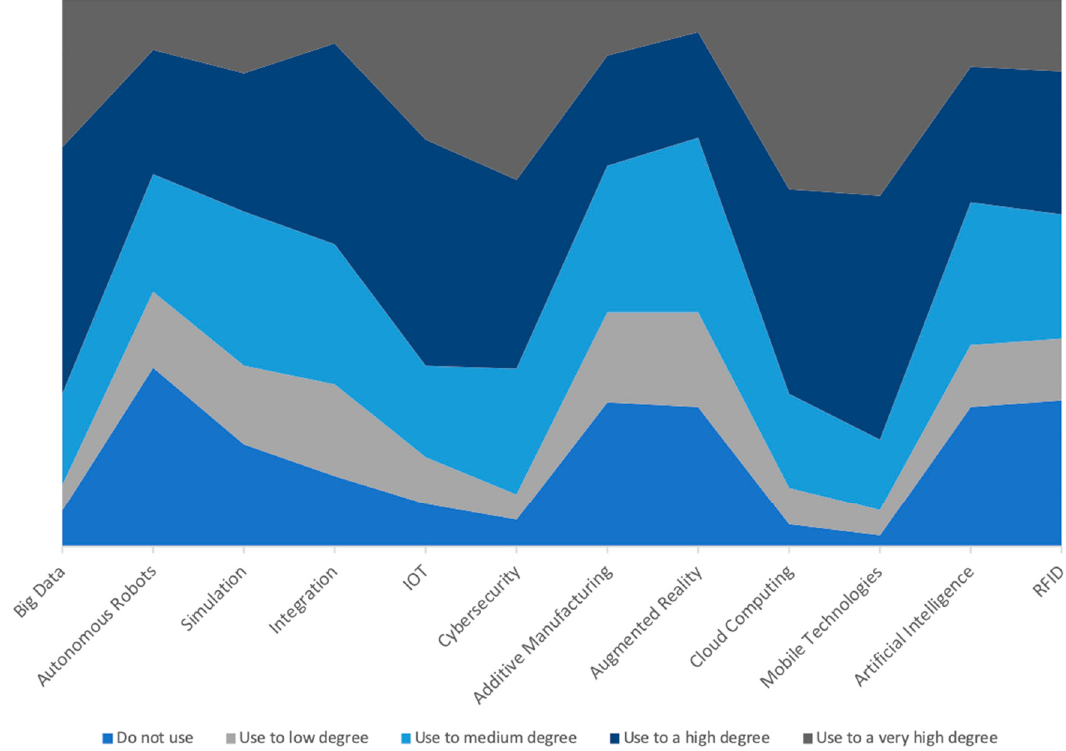
Figure 2. Industry 4.0 technologies (surface chart).